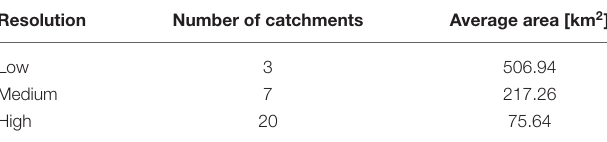
TABLE 2 | Catchment resolution